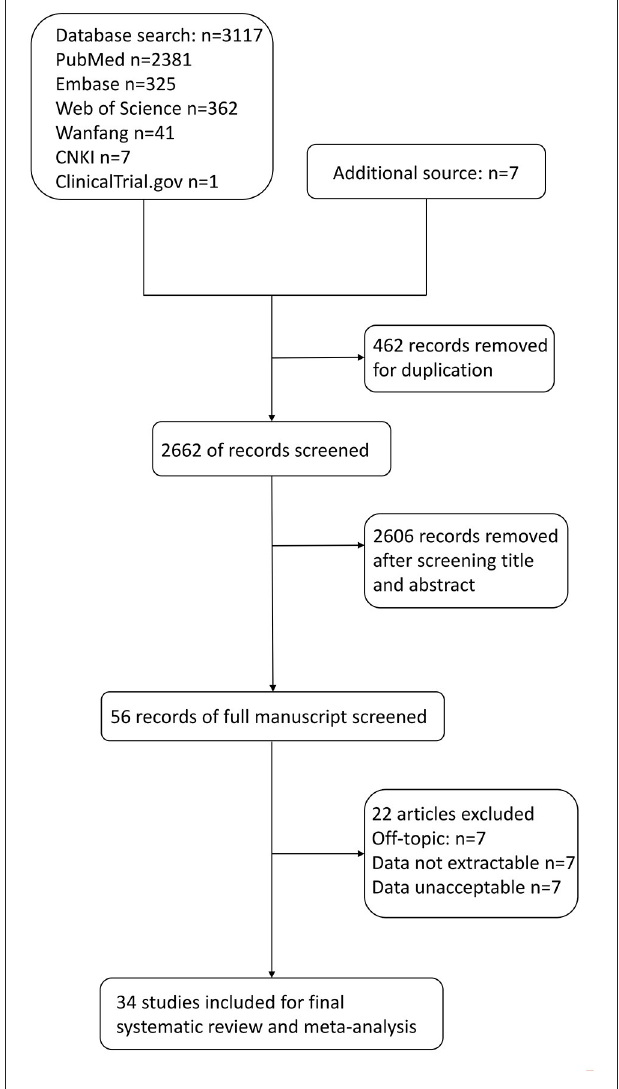
FIGURE 1 | Flow diagram for selection of studies on correlations between maternal copper levels and preeclampsia (PE) in